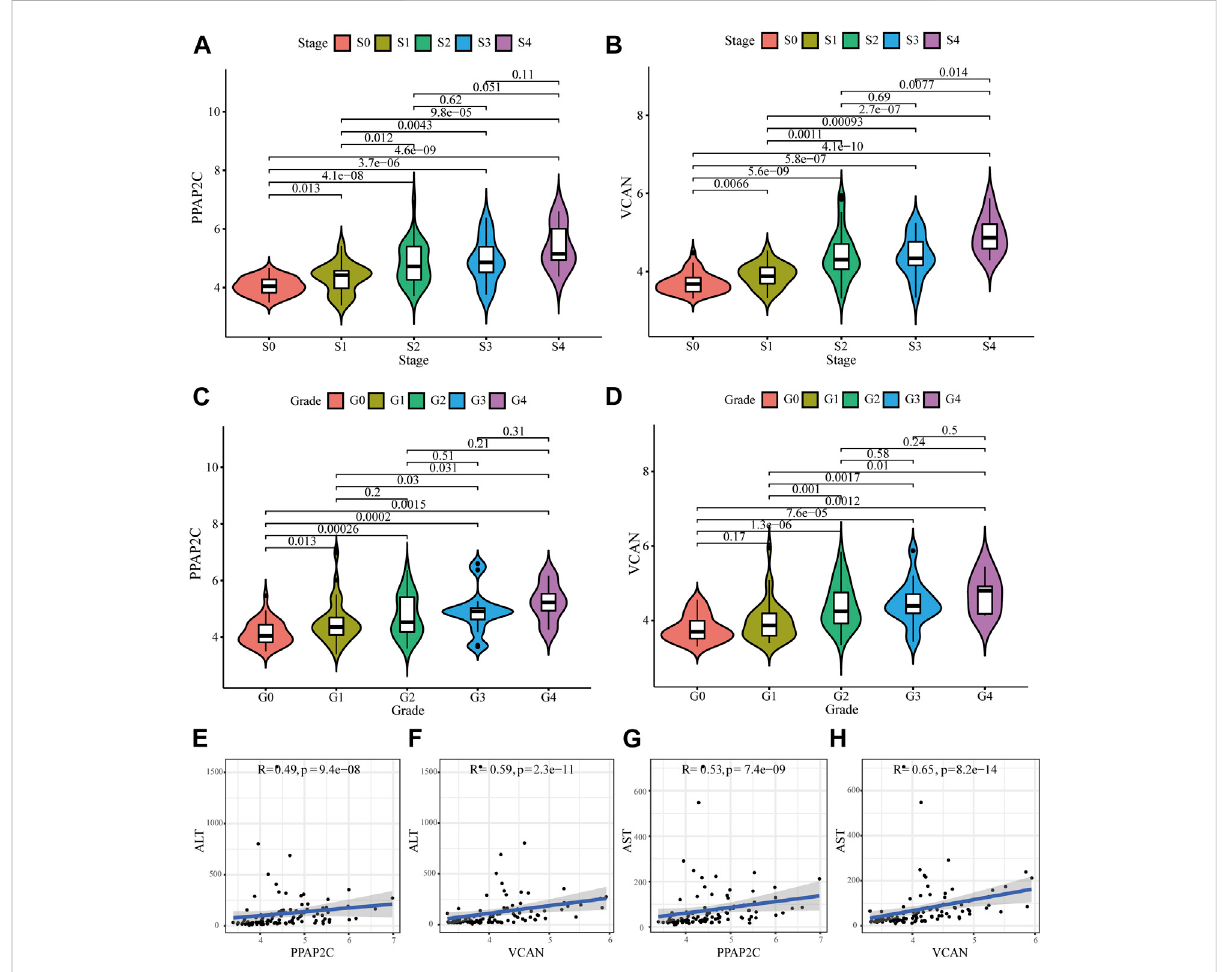
FIGURE 5 Relationshipsbetweenthediagnosticbiomarkersandclinicopathologicalfeatures. (A – D) TheexpressionlevelofPPAP2CandVCANindifferent groups divided by clinical characteristics. (E – H) The correlation analysis between PPAP2C and VCAN and ALT, and